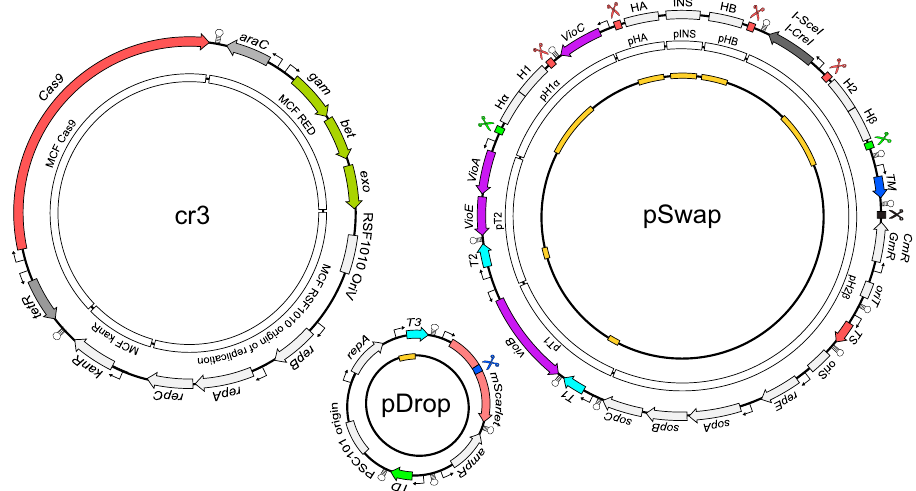
Fig. 3 Detailed map of the plasmids cr3Ec, pSwap and pDrop. The outer layer contains relevant features of each plasmid. The white inner layer (if applicable) represents the modular parts prior to assembly using MoCloFlex (MCF) or the CRISPR SWAPnDROP assembly system. The black inner layer (if applicable) shows the location of variable elements (orange) of the plasmids speci fi c for each edit. Cas9 and meganuclease target sites are indicated by scissors. The sgRNA loci and the respective target sites share the same